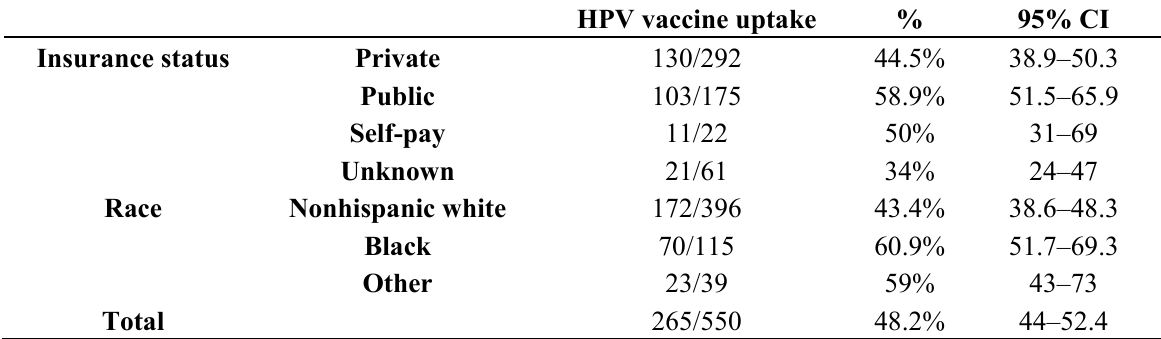
Table S1. HPV vaccine uptake by insurance status and race: supplemental data for Table